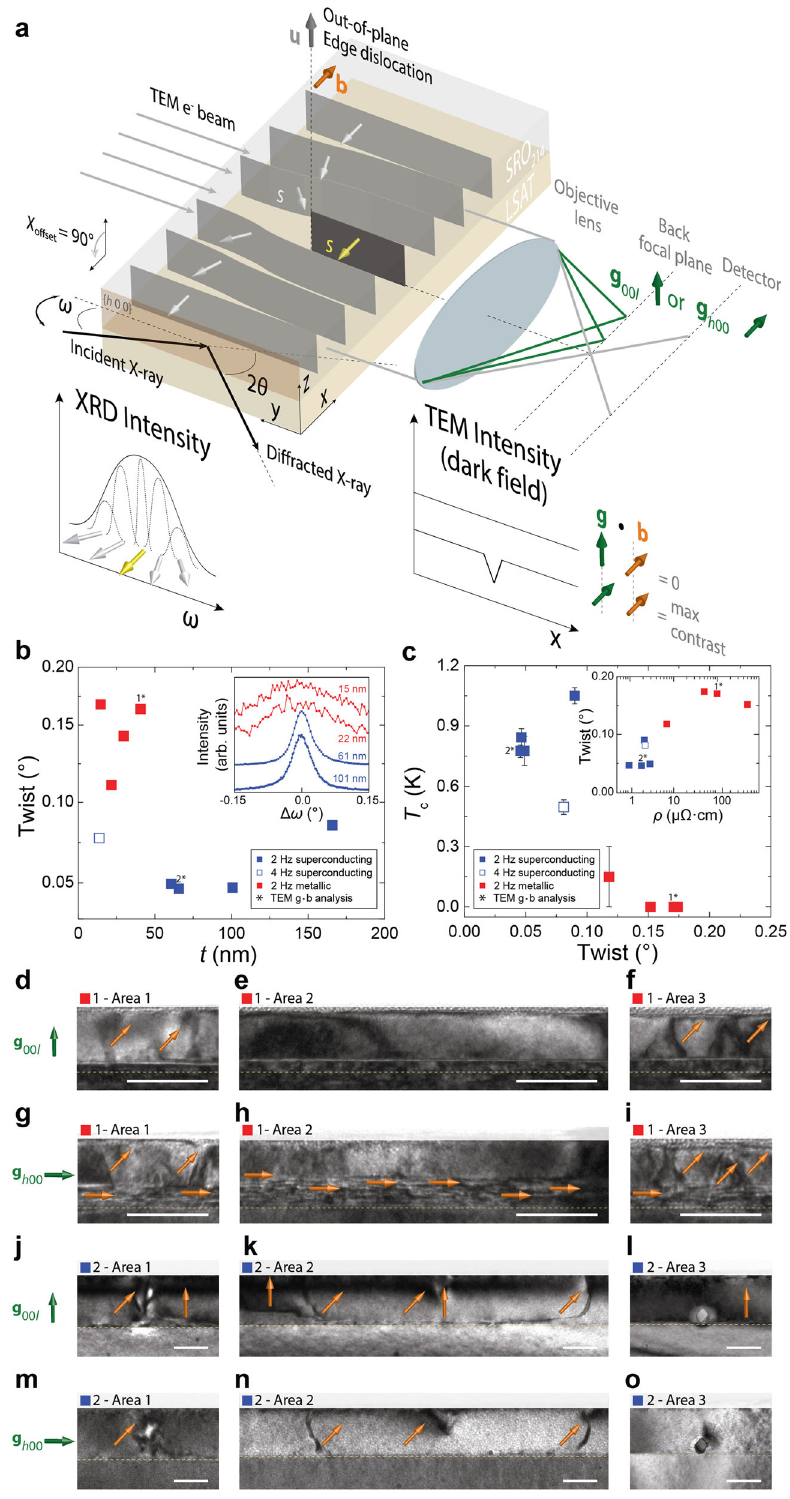
Fig. 3j located in the Ru-de fi cient layer (con fi rmed in Fig. 4g – i), is also dislocation related as it might be the result of a combination of features such as Ru-de fi ciency, interface effect and dislocations.